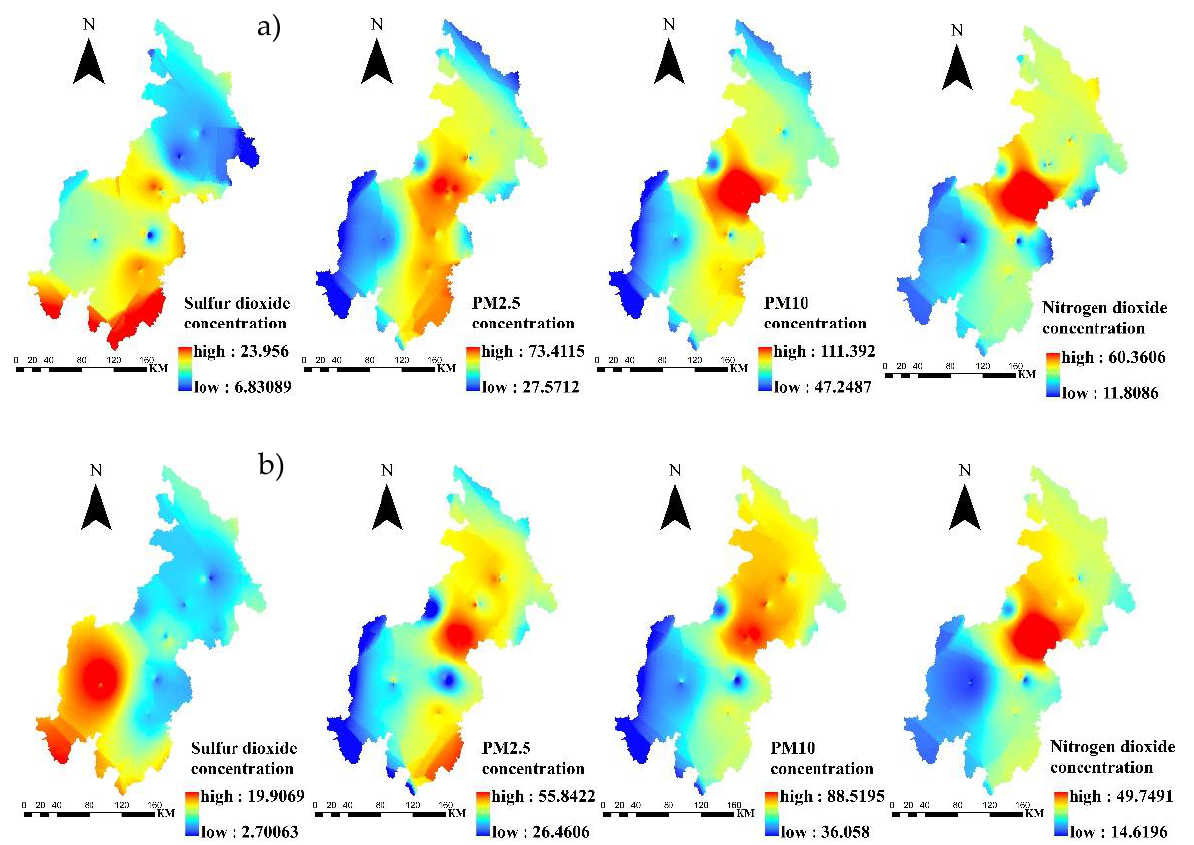
Figure 4. Spatially interpolated concentrations of the four pollutants ( a ). 2015; ( b ). 2018.